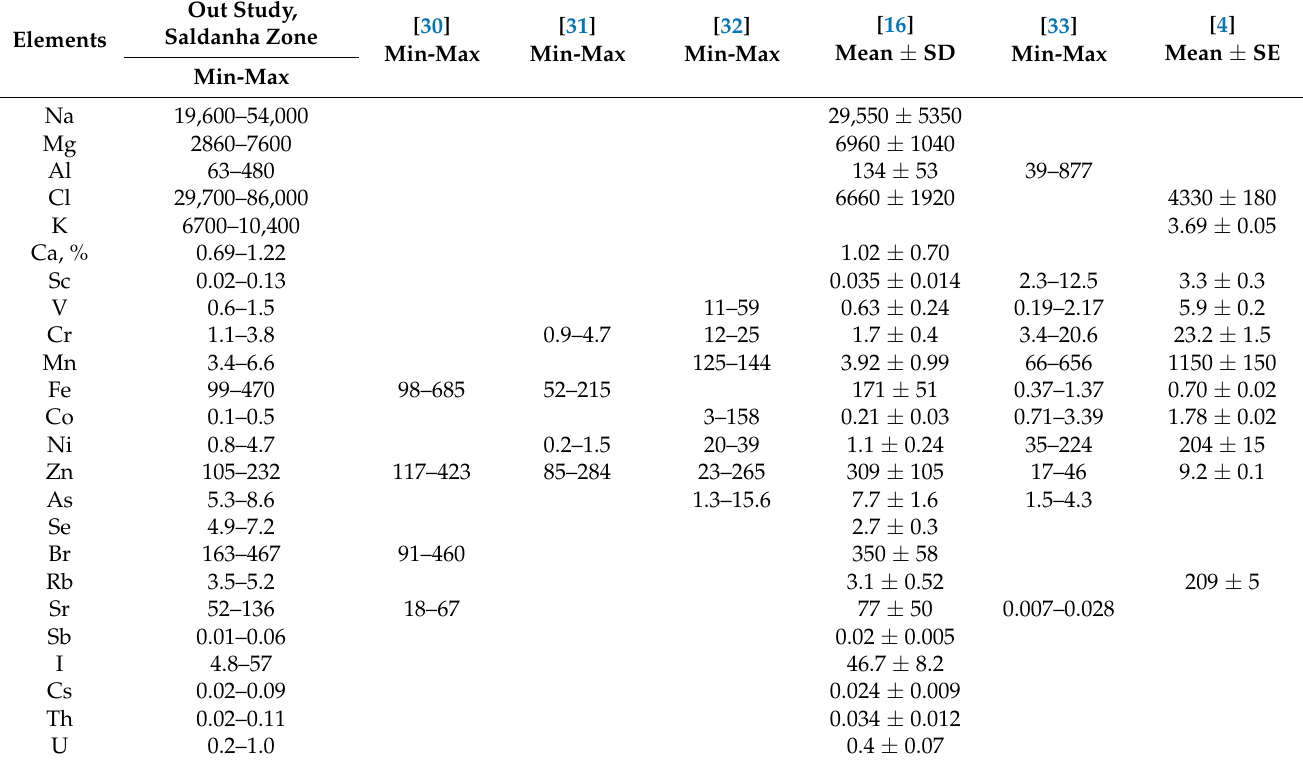
Table 4. Concentrations of elements in the soft tissue of Mytilus galloprovincialis (dry weight,